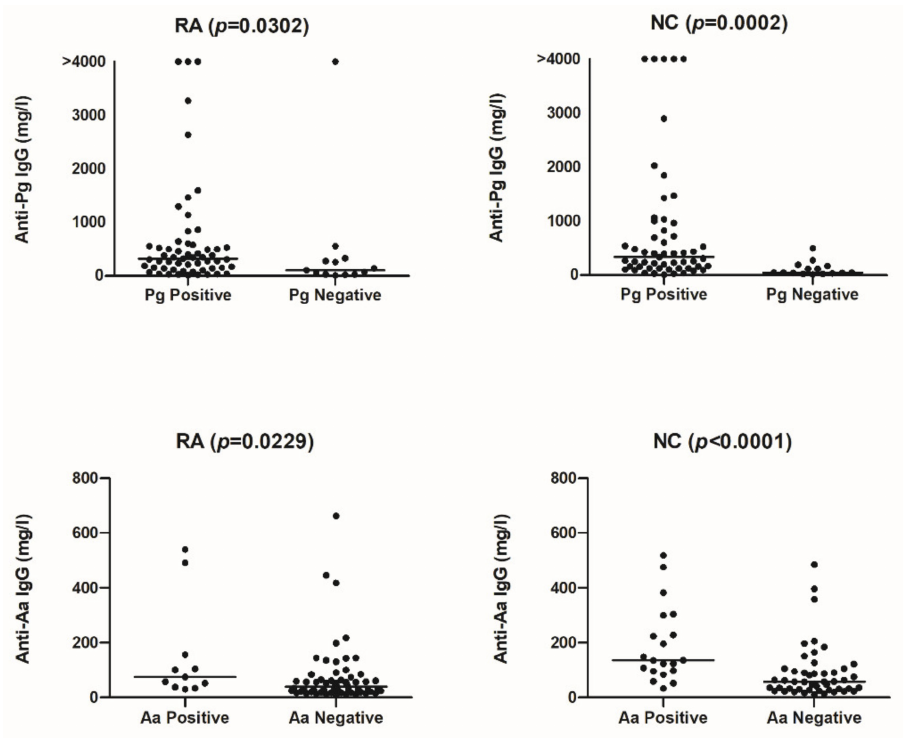
Figure 1. Levels of anti- P. gingivalis (Pg) and anti- A. actinomycetemcomitans (Aa) antibodies in RA patients and non-RA controls (NC) positive or negative for these bacteria. Lines represent the